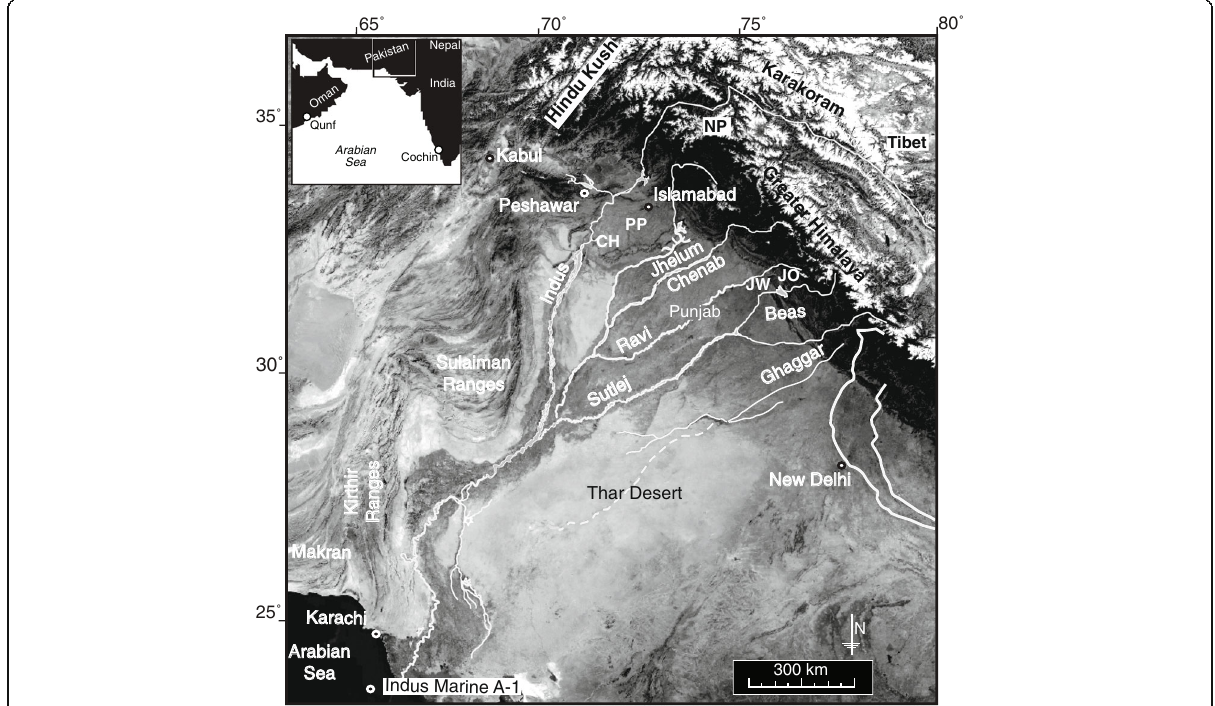
Fig. 1 Satellite image of the Indus Basin from Google Earth. Map shows the major tributaries and trunk stream of the Indus, together with the main ranges discussed in this study. PP — Potwar Plateau; CH — Chinji; NP — Nanga Parbat; JW — Jawalamukhi; JO —